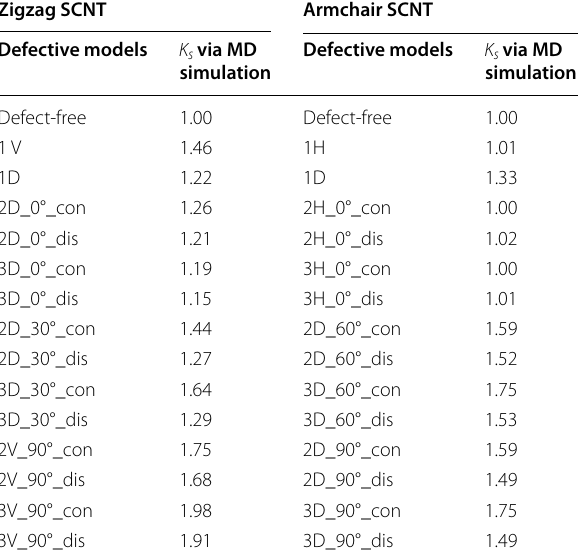
Table 2 Stress concentration factors of defective models for zigzag and armchair SCNTs Zigzag SCNT Armchair SCNT